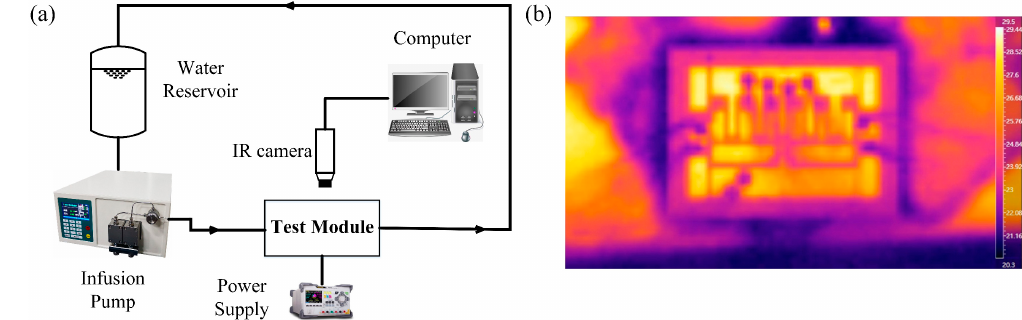
Figure 3. ( a ) Close-loop of the experimental test platform; ( b ) an IR camera was focused on the GaN power amplifier chips area (o ff working